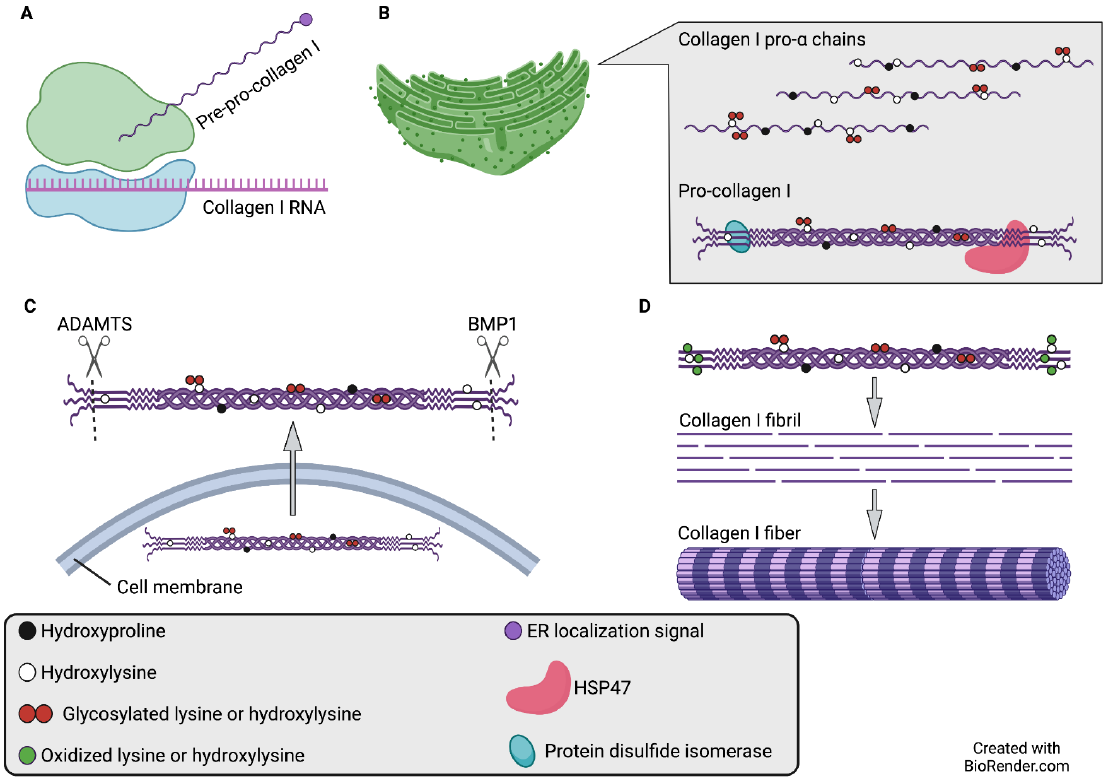
Figure 1. Synthesis of collagen I, a prototypical fibrillar collagen. ( A ) Collagen α chains are synthe- sized in ER-bound ribosomes as pre-pro-collagens. ( B ) Full-length pre-pro-collagen molecules are translocated to the ER and are known as pro- α chains when the ER localization signal is removed. Pro- α chains then undergo a series of post-translational modifications including proline hydroxyla- tion (catalyzed by P4H), lysine hydroxylation (catalyzed by LH1-3), and/or lysine and hydroxyly- sine glycosylation (catalyzed by COLGALT1, COLGALT2, and/or LH1-3). Association of three post- translationally modified chains results in the formation of a pro-collagen molecule. Chaperone pro- teins such as HSP47 and protein disulfide isomerase facilitate pro-collagen stabilization. ( C ) Pro- collagen molecules are secreted into the extracellular space by exocytosis. (For simplicity, secretory granules are not shown.) Amino acid residues in pro-collagen N- and C- terminal regions, known as pro-peptides, are cleaved by ADAMTS and BMP1, respectively. Pro-peptide residues retained after cleavage are known as telo-peptides. ( D ) Individual collagen molecules self-assemble into col- lagen fibrils, which are stabilized by oxidation and crosslinking of telo-peptide lysines and hydrox- ylysines. This process results in a “quarter - staggered” fibril organization pattern. Multiple collagen fibrils aggregate to form collagen fibers, which are visible with light microscopy. Abbreviations: ADAMTS: a disintegrin and metalloproteinase with thrombospondin motifs; BMP1: bone morpho- genetic protein 1; COLGALT: procollagen galactosyltransferase; ER: endoplasmic reticulum; HSP47: heat shock protein 47; LH: lysyl hydroxylase; P4H: prolyl-4-hydroxylase.